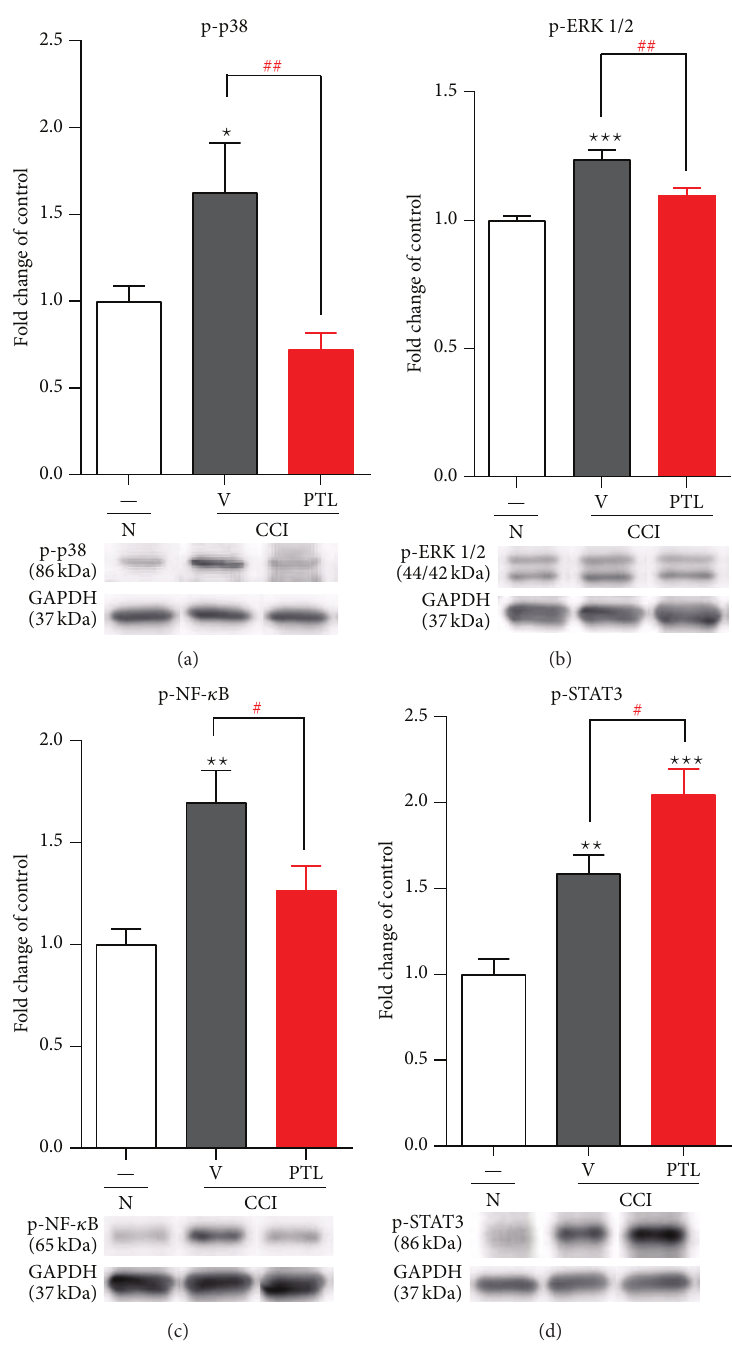
Figure 4: Effects of PTL on the protein levels of p-p38, p-ERK1/2, p-NF- 𝜅 B, and p-STAT3 in the spinal cord 7 days after CCI. Seven days after CCI in the lumbar dorsal cord a significant increase of p-p38 (a) and p-ERK1/2 (b) proteins levels was observed. Repeated administration of PTL reduced the upregulation of p-p38 (a) and p-ERK 1/2 (b) protein levels in comparison with those of CCI-exposed rats. Similarly, seven days after CCI in the ipsilateral dorsal spinal cord, p-NF- 𝜅 B (c) protein level was significantly upregulated by nerve injury and repeated PTL administration inhibited the level of p-NF- 𝜅 B (c). At day 7 after CCI, strong upregulation of p-STAT3 was observed (d). Chronic PTL- treatment caused enhancement of p-STAT3 (d). The Western blot data are presented as the mean ± SEM and represent the normalized averages derived from analyses of 5–7 samples for each group. Intergroup differences were analyzed using ANOVA followed by Bonferroni’s multiple comparison test. ∗ 𝑃 < 0.05 , ∗∗ 𝑃 < 0.01 , and ∗∗∗ 𝑃 < 0.001 indicate significant differences compared to na¨ıve rats. # 𝑃 < 0.05 and ## 𝑃 < 0.01 indicate significant differences compared with the vehicle-treated CCI-exposed rats. N-na¨ıve, V-vehicle, and PTL-parthenolide. The immunoblots shown are representative of 5–7 individual